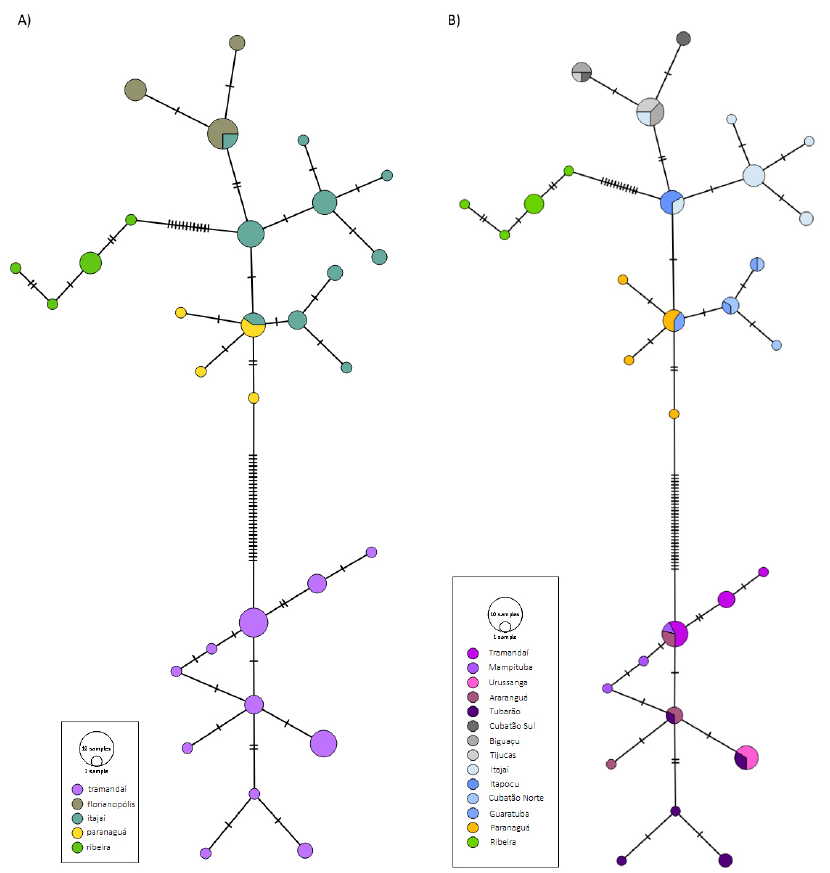
FIGURE 3 | Haplotype network using Median-Joining for only cox1 sequences of Hisonotus leucofrenatus samples. A. Colors represent groups